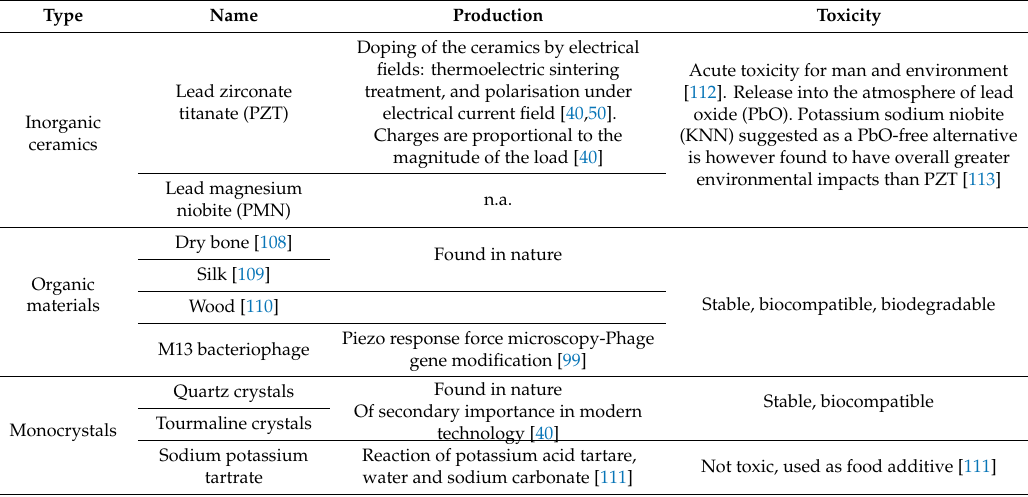
Table 5. Qualitative information on the production of Shape Memory Ceramics